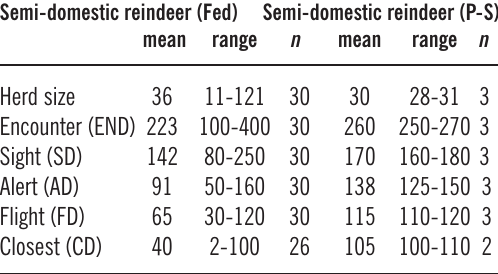
Table 4. Observed response distances of semi-domestic reindeer in different Finnish reindeer-herding coopera- tives and areas (winter feeding common) and in Pohjois- Salla (no feeding), when provoked by an observer on foot/ snowshoes in 2010-12 (data pooled across years).